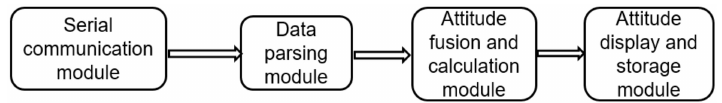
Figure 6. Overall structure of the software